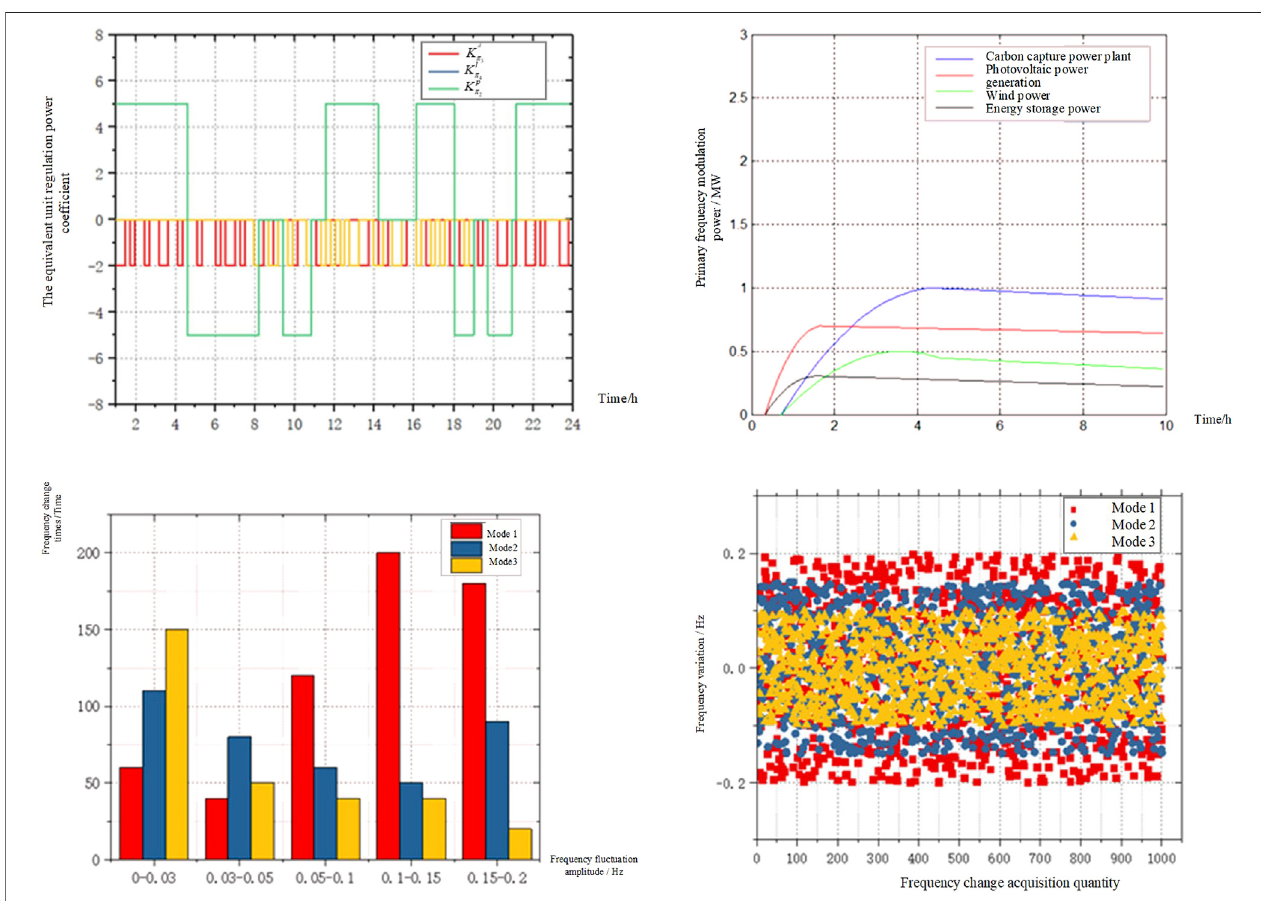
FIGURE 7 | (A) The variation diagram of system equivalent unit regulated power coef fi cient in Mode 2; (B) the active power adjustment curve of each power in the system; (C) the frequency variation amplitude in Mode 3; (D) the distribution of frequency variation in mode three.